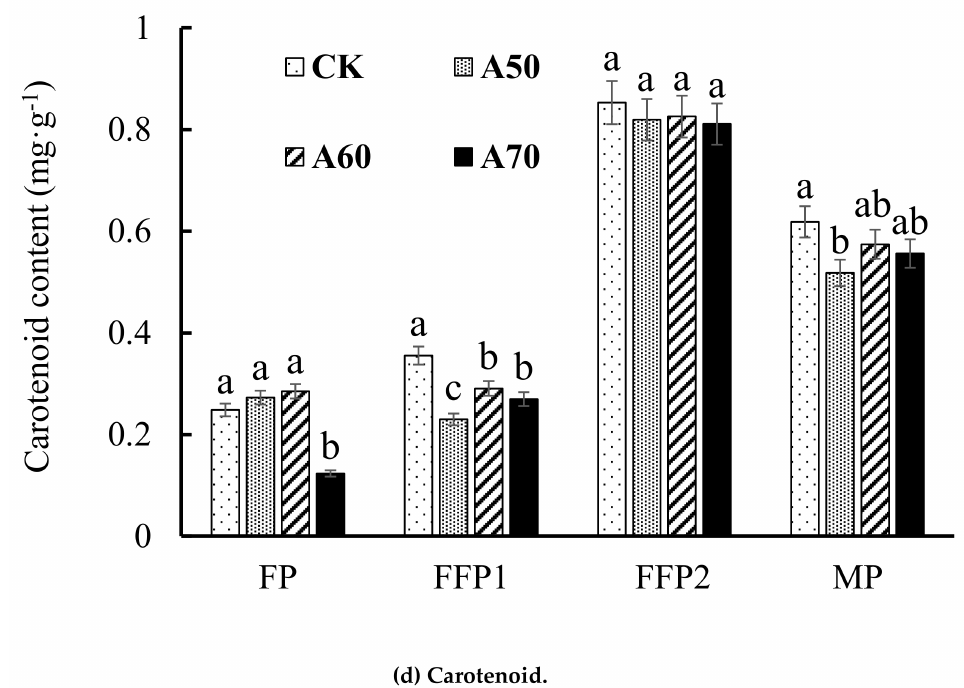
Figure 3. Photosynthetic pigment content in leaf at di ff erent growth stages under alternate drip irrigation (ADI). Note: Di ff erent small letters mean significant di ff erence ( p < 0.05) among the di ff erent treatments in same growth stage according to Duncan test. FP was 0–50 d after tomato planting to field,